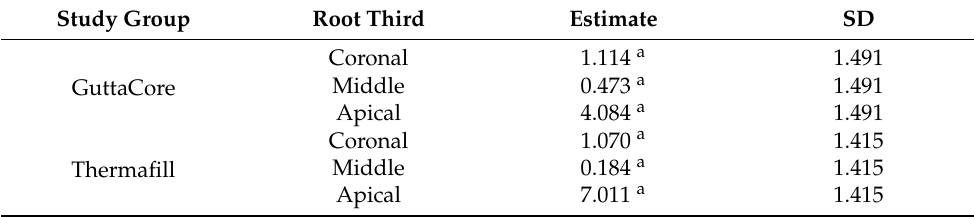
Table 4. Descriptive analysis of the proportion (%) between the volume of the root canal system and the remaining carrier-based root canal filling material volume from the coronal, middle and apical